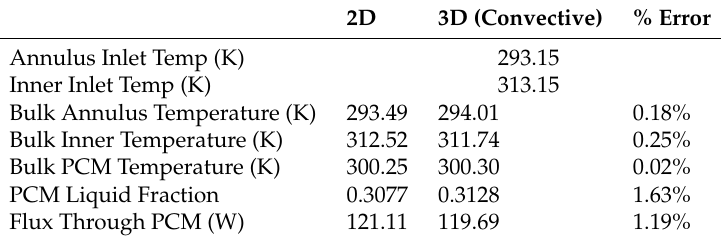
Table 6. Comparison of results with and without natural convection